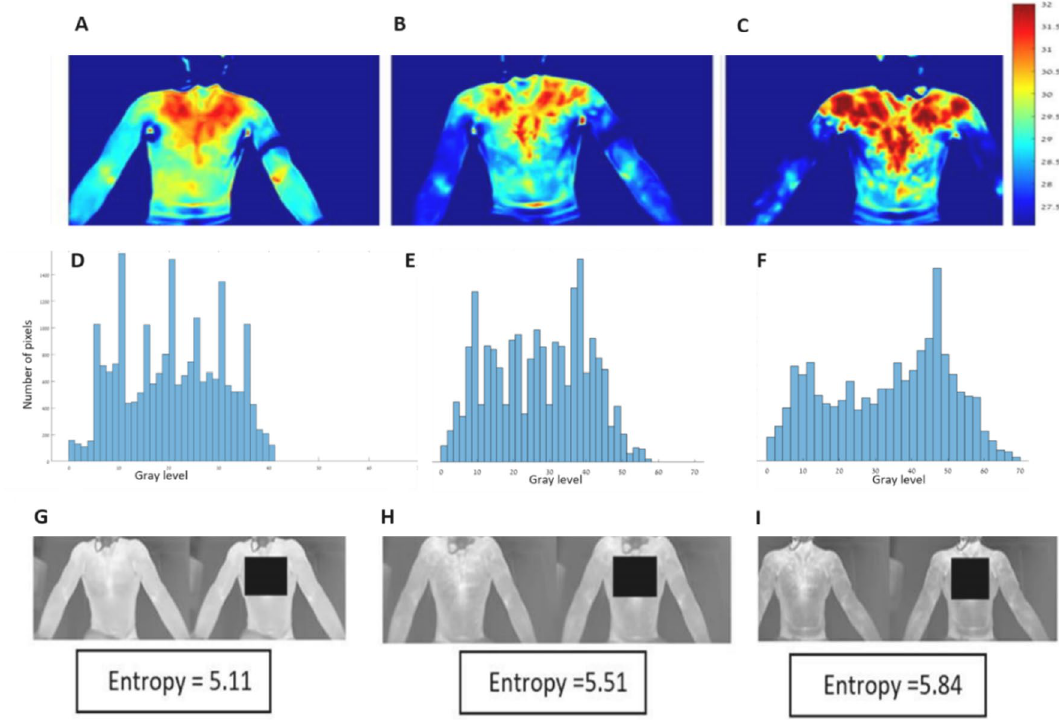
Figure 5. The thermal images and entropy as observed at three time points in the exercise test. ( A , D , G ) at the beginning of the exercise (before the aerobic threshold), ( B , E , H ) between the aerobic threshold (AT) and the respiratory compensation point (RCP), and ( C , F , I ) towards the end of the exercise (after the RCP). The bottom row of figures shows the manually marked